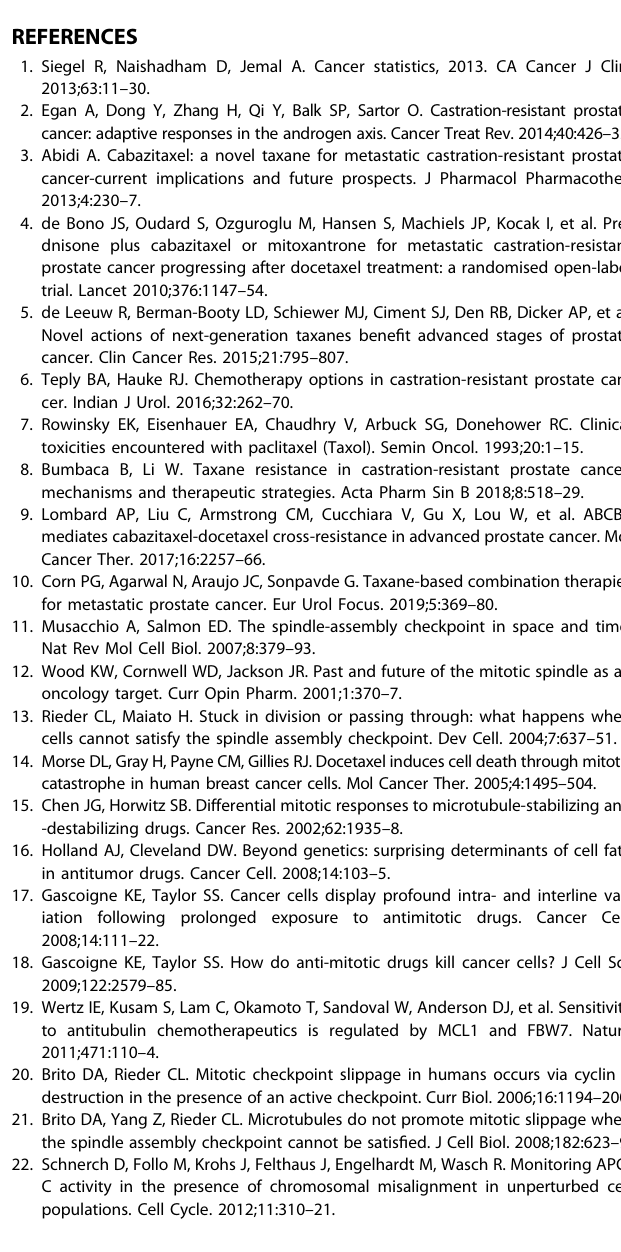
Fig. 7 Model. Antimitotic drugs including the Taxane CBZ induce mitotic block. Sensitive cells exit block by mitotic catastrophe, while resistant cells remain in block and complete mitosis after drug decay. Mps1 inhibitors force mitotic exit inducing mitotic catastrophe, thus potentiating cytotoxicity and reversing resistance to